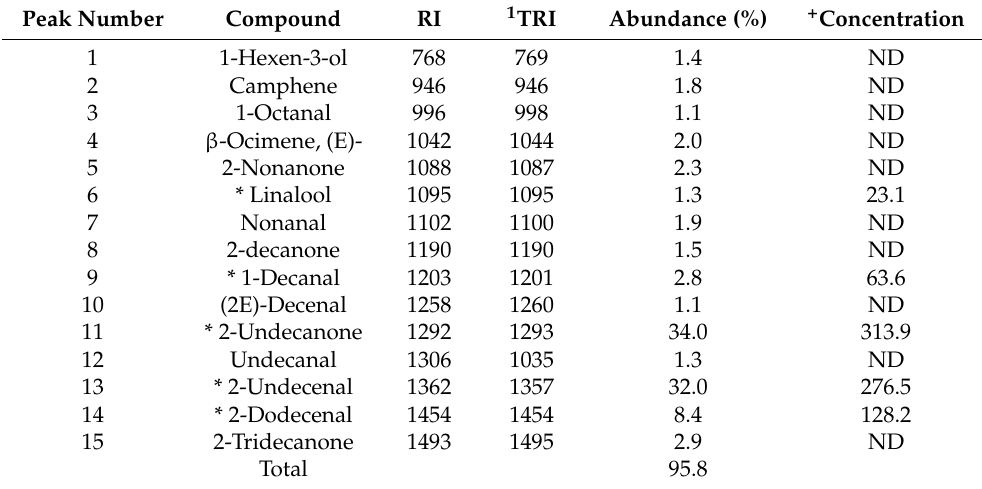
Table 1. Volatile composition of the essential oil of Zanthoxylum limoncello grown in Puebla-M é xico. Peak Number Compound